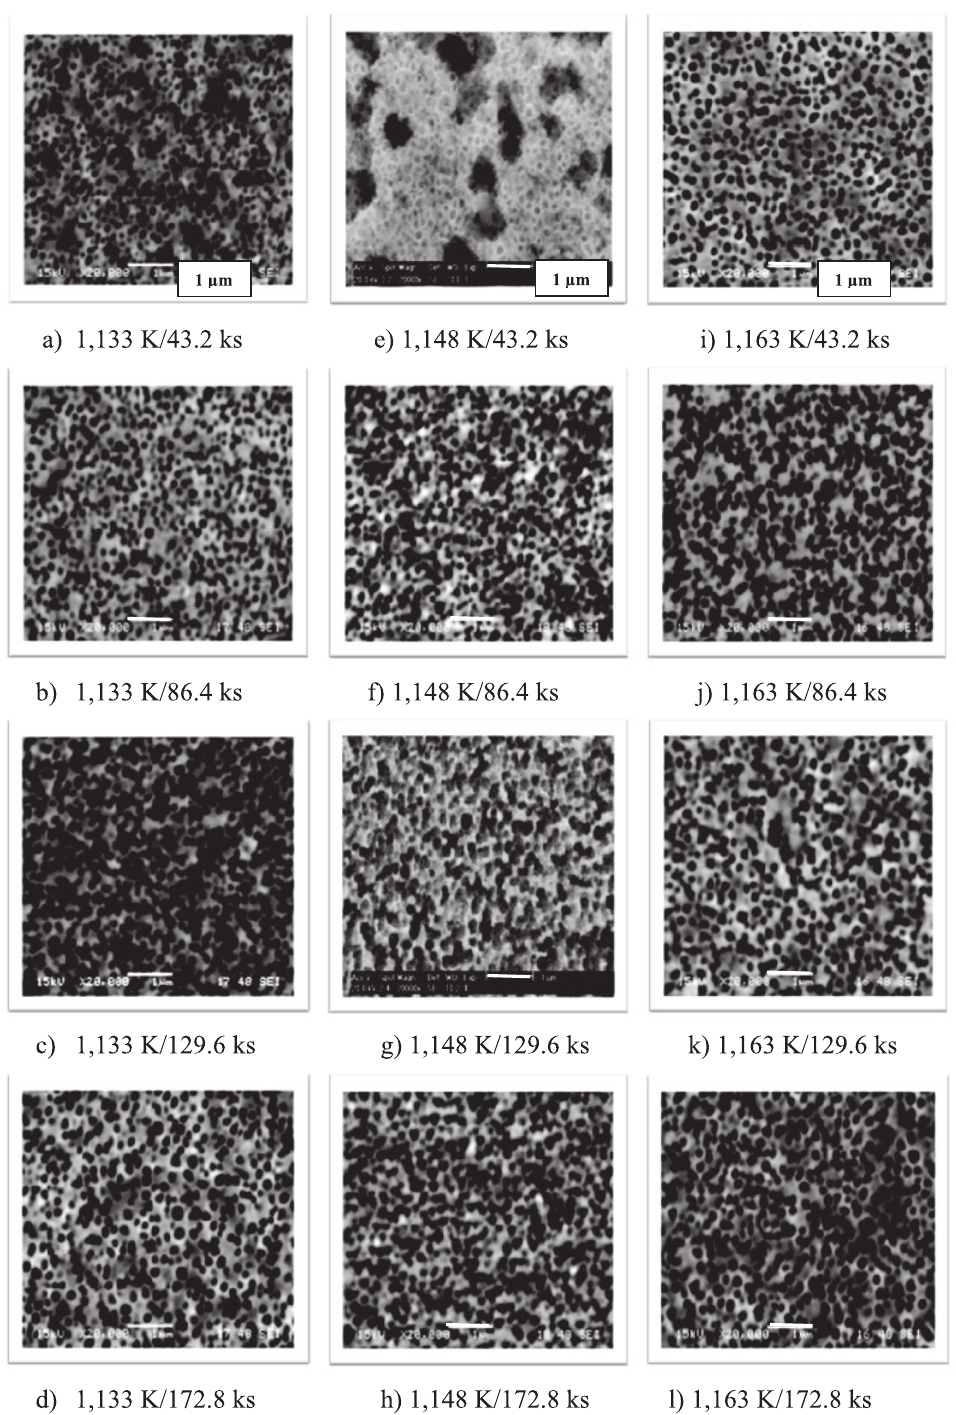
Fig. 3: Microstructures of specimens with solutionizing temperature of 1,458 K/14.4 ks and various aging